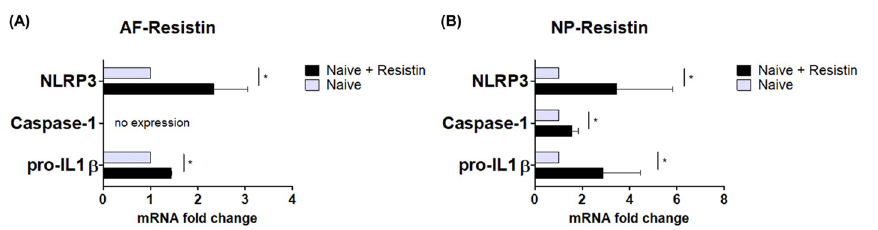
Figure 4. mRNA gene expression of the inflammatory mediators of NLRP3, Caspase-1, and pro-IL1β between IVD cells and hResistin stimulation, compared to unstimulated naïve IVD control groups (*p < 0.05, n = 5/